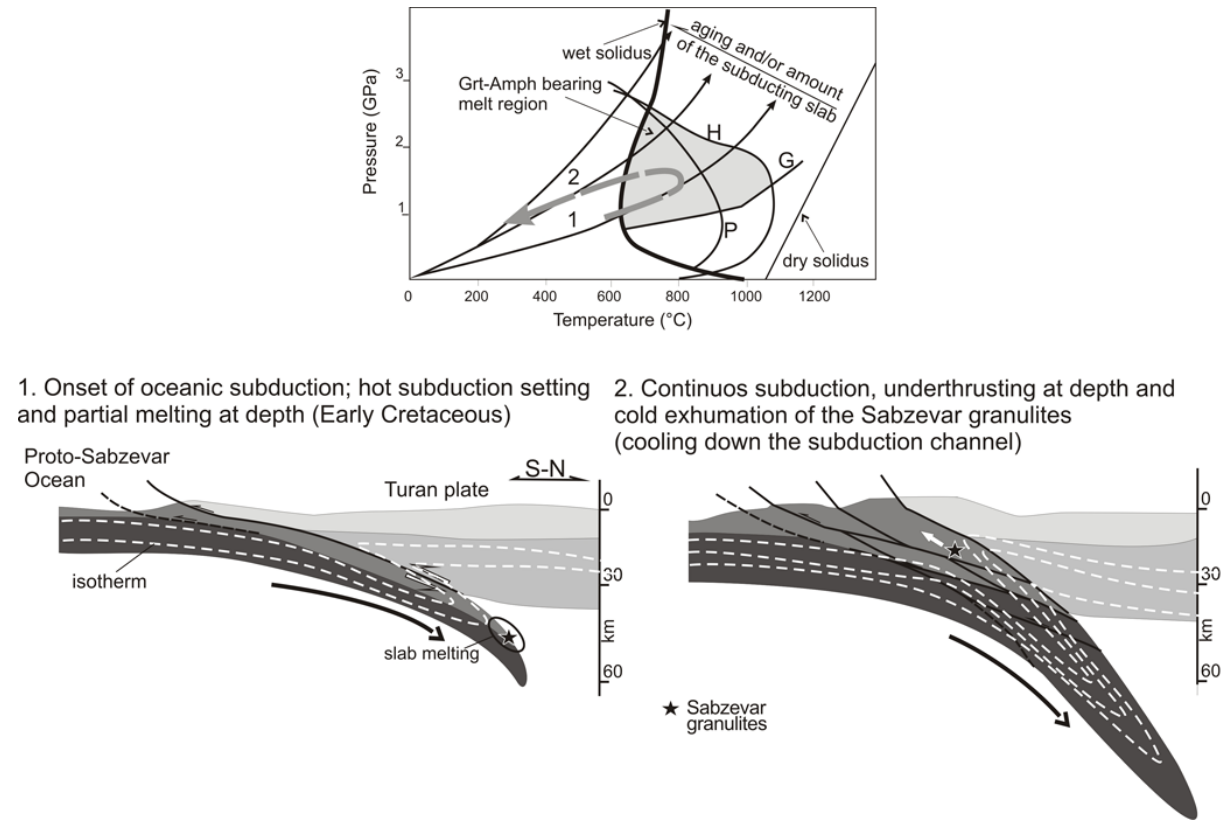
Fig. 13. Conceptual two-stage geodynamic model to accomplish for the anticlockwise P - T evolution recorded by the Sabzevar granulites. This P - T path is interpreted as consequence of transition from an infant to a mature stage of subduction of the Proto-Sabzevar Ocean below the Turan plate. The top panel (modified and re-adapted after Peackock et al., 1994 and Martin, 1999) show the dry and wet solidus of tholeiite and the inferred P - T trajectories and geothermal gradients in the subduction channel as a function of the age and/or amount of the subducted oceanic lithosphere. Trajectory 1 and 2 refers to a nascent and mature subduction, respectively. Slab melting is predicted only when young lithosphere subducts or at the early stages of subduction. The dashed grey arrow schematically depicts the P - T evolution of the Sabzevar granulites. Key to labels: G, and P, line delimiting garnet and plagioclase stability, respectively; H,